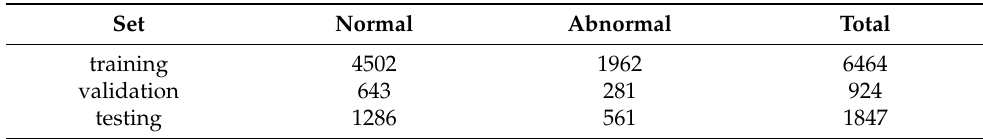
Table 8. Detail of each dataset on images.